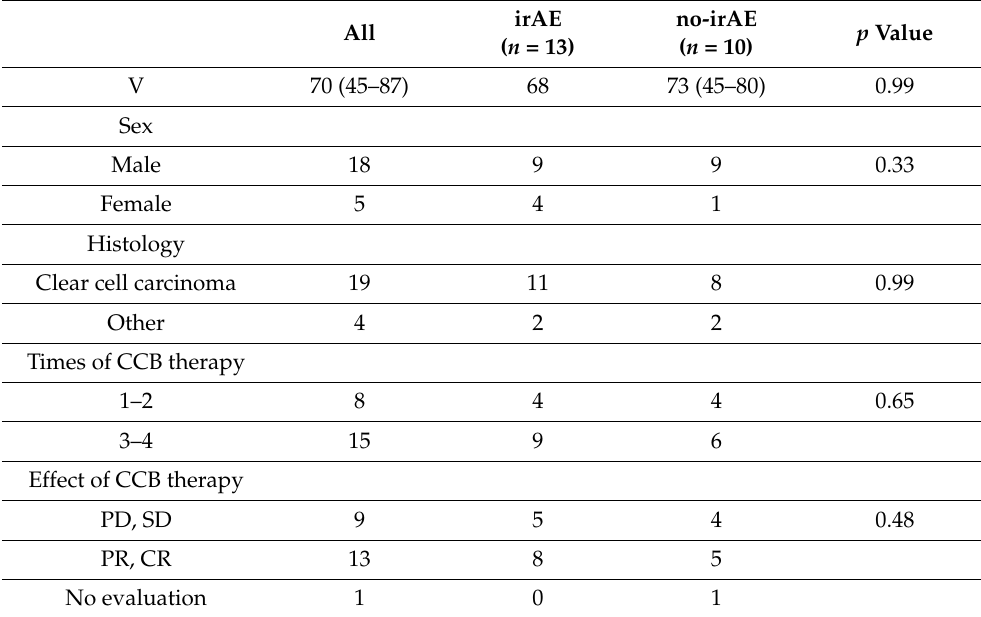
Table 1. Comparison of clinical characteristics between no-immune-related adverse event (irAE) and irAE